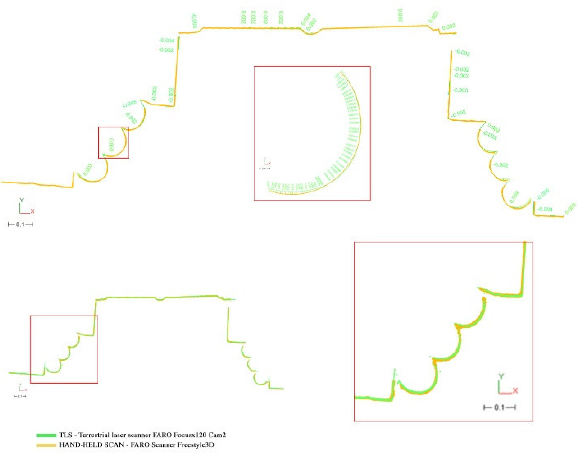
Figure 3. Roughness index maps on the two range-based sensors. TLS (up) and hand-held scanner (down)